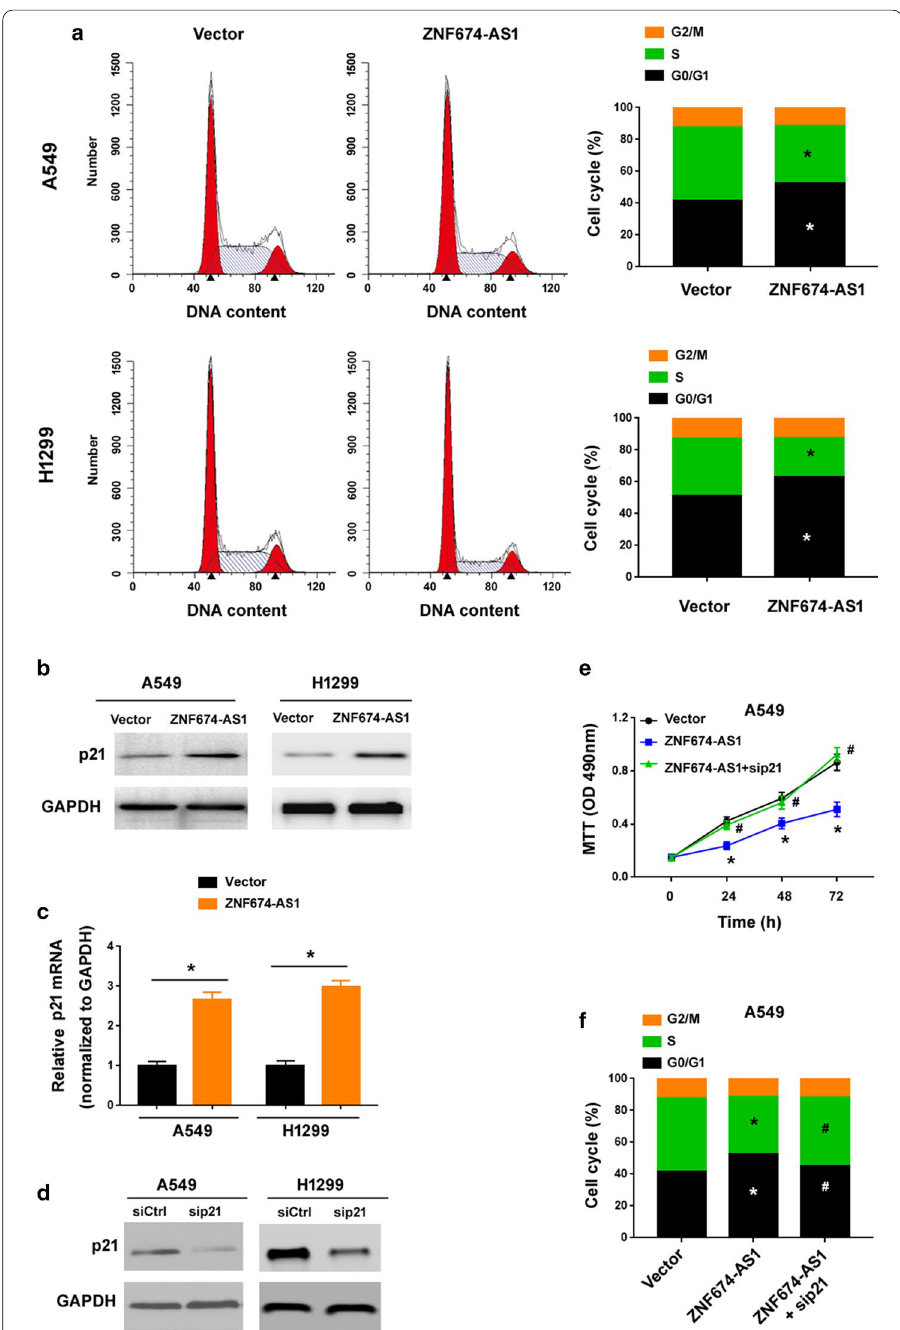
Fig. 5 ZNF674-AS1 causes a G0/G1 cell cycle arrest through upregulation of p21. a Flow cytometric analysis showed that overexpression of ZNF674-AS1 arrested NSCLC cells at the G0/G1 phase. * P < 0.05 compared to vector-transfected cells. b Western blot analysis of indicated proteins. c ZNF674-AS1 overexpression increased the levels of p21 mRNA in NSCLC cells. * P < 0.05. d Knockdown of p21 in NSCLC cells by transfection of siRNAs. siCtrl: control siRNA; sip21: p21-targeting siRNA. e MTT assay showed that p21 knockdown rescued ZNF674-AS1-mediated growth of A549 cells. f Cell cycle analysis conducted in A549 cells transfected with indicated constructs. * P < 0.05 compared to vector-transfected cells; # P < 0.05 compared to cells transfected with ZNF674-AS1